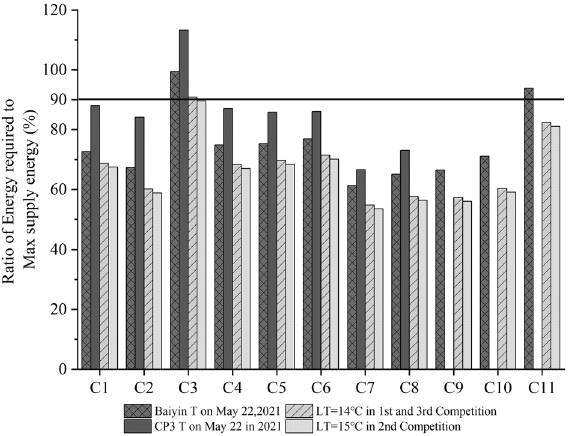
Figure 6. The ratio of the total energy consumed for a marathon to the maximum energy supply T is the temperature, and LT is the lowest